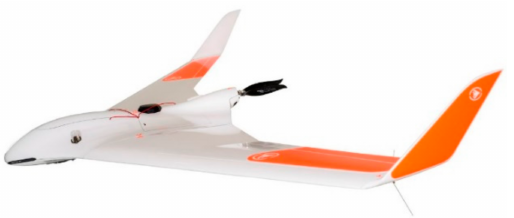
Figure 1. Bramor ppX UAV [3]. Figure is obtained with the permission, from webpage of C-Astral Aerospace, Ltd.